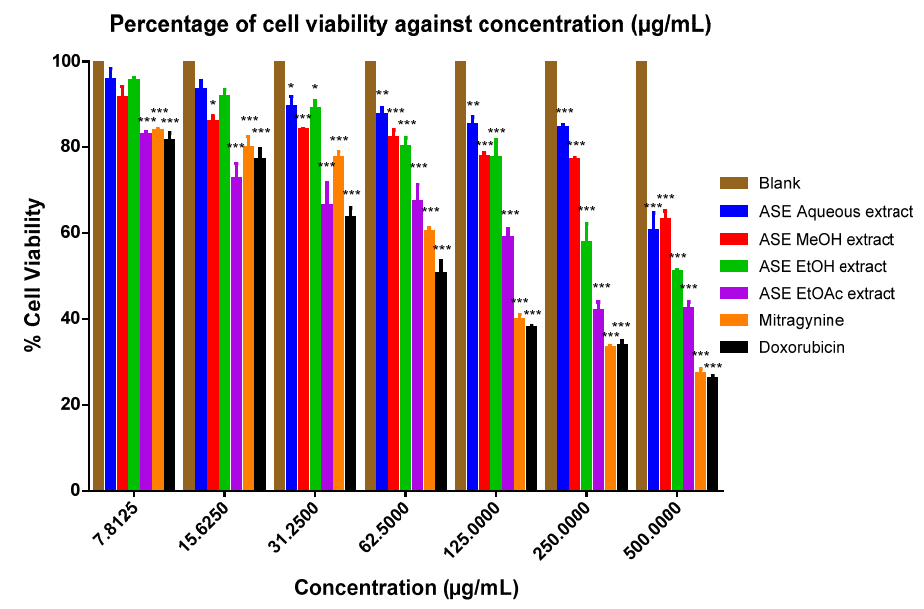
Figure 2. Percentage viability of HeLa Chang liver cells against various concentrations of treatment with mitragynine, doxorubicin, and M. speciosa ASE leaf extracts. Data shown as mean ± SEM ( n = 6). * p < 0.05, ** p < 0.01, *** p < 0.001 compared with DMSO as blank (one-way ANOVA, followed by Dunnett’s test).